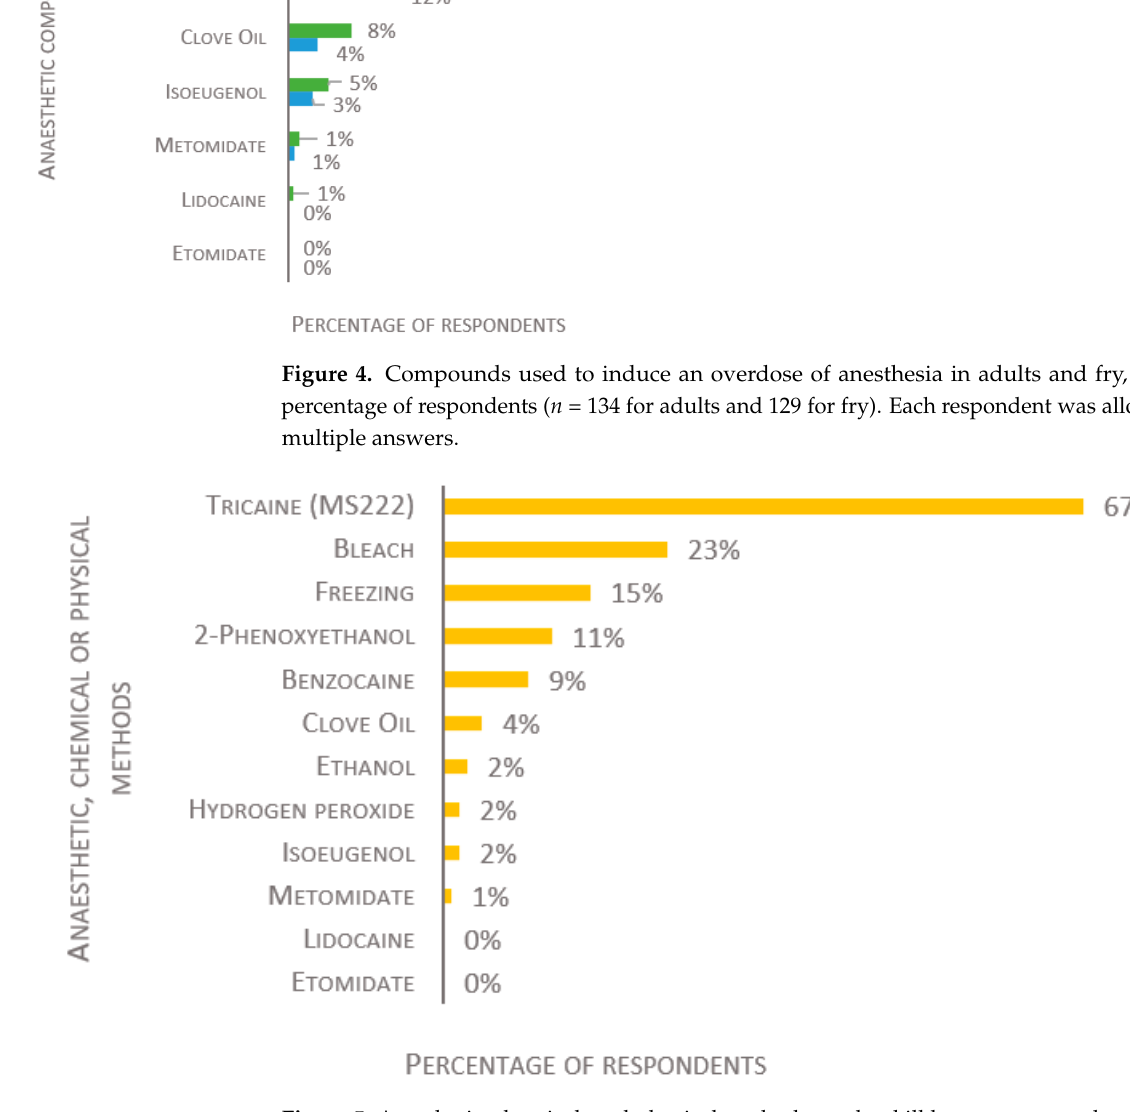
Figure 5. Anesthetic, chemical, and physical methods used to kill larvae, presented as percentage of respondents ( n = 124). Each respondent was allowed to select multiple answers.